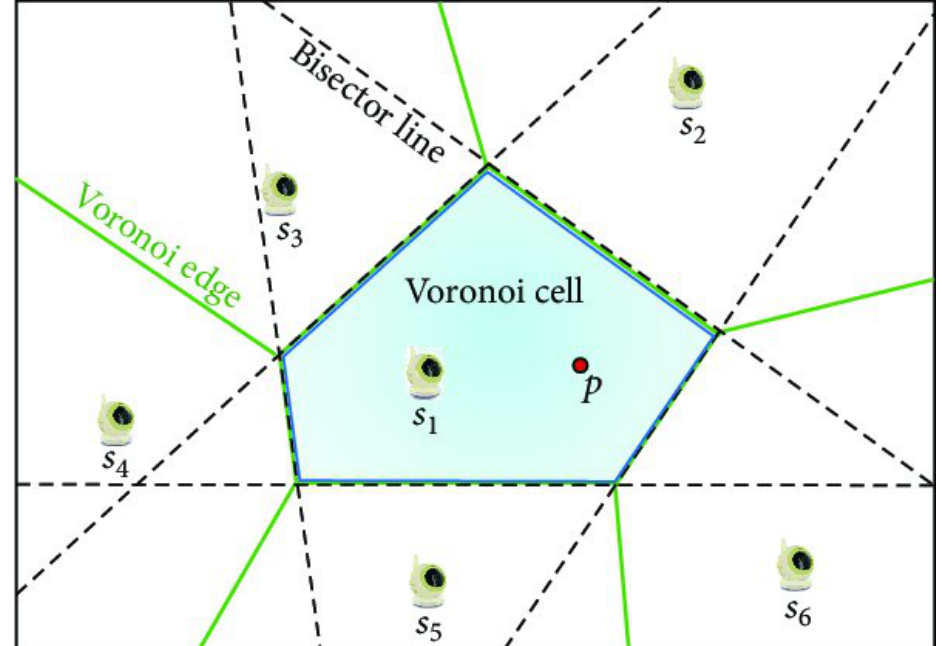
Figure 2. Voronoi cells (CC BY 3.0)